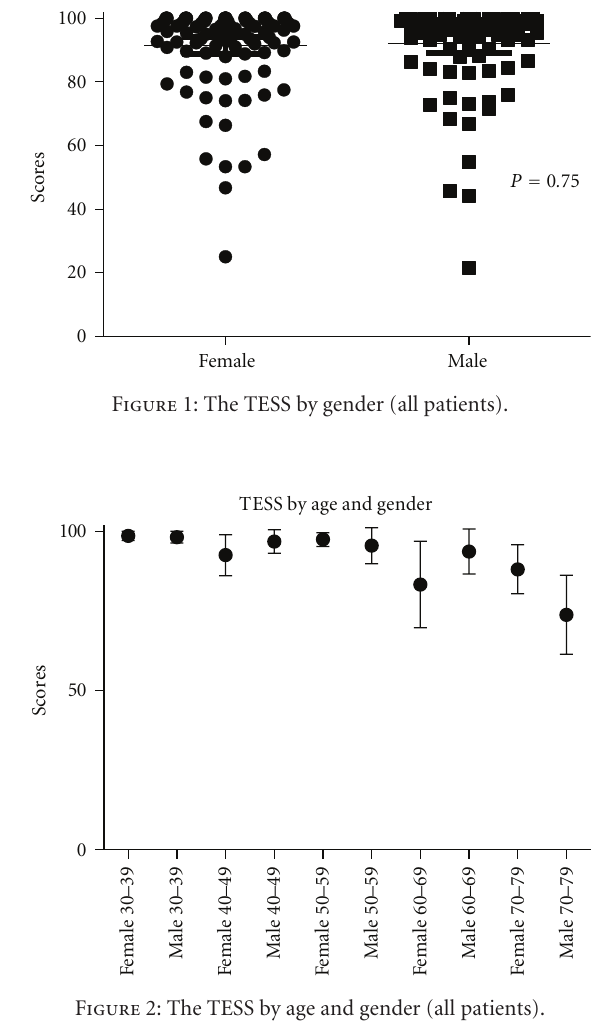
Figure 2: The TESS by age and gender (all